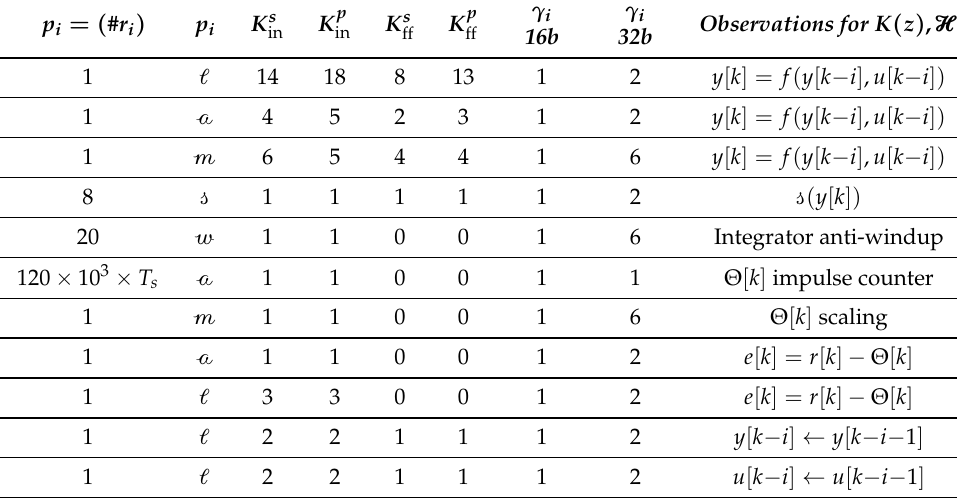
Table 9. Encountered operations in the implementation of the 2DOF structure for the DC motor case study in the hypothesis of a base word length of L = 16 bits and two considered quantization levels for the controller coefficients: 16-bit and 32-bit lengths, respectively.